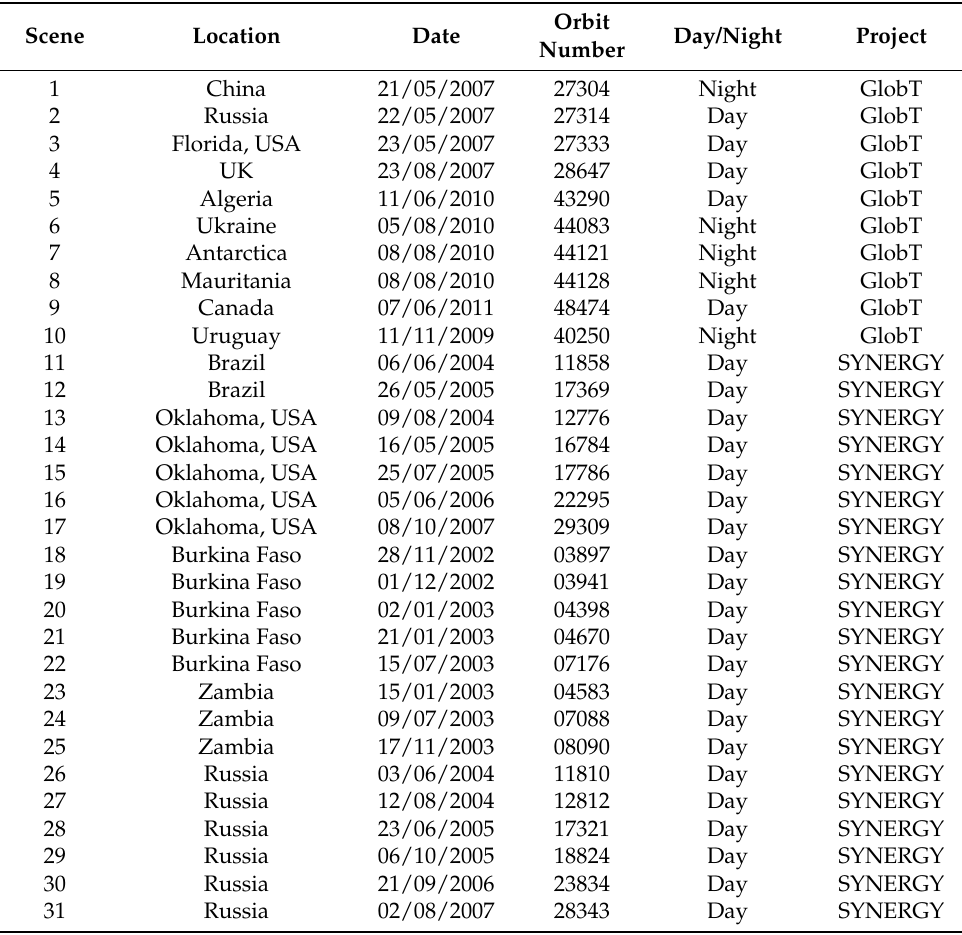
Table 3. SYNERGY and DUE GlobTemperature project manually masked scenes used to calculate cloud mask performance metrics (information collated from